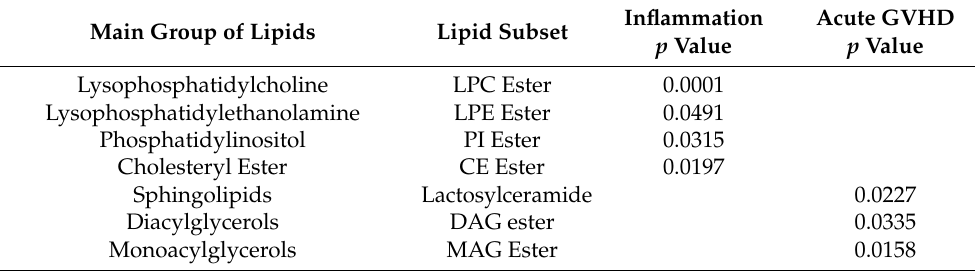
Total serum levels were determined for the 14 lipid classes phosphatidylcholines, lysophosphatidylcholines (LPC), phosphatidylethanolamines, lysophosphatidylethanolamines (LPE), phosphatidylinositols (PI),